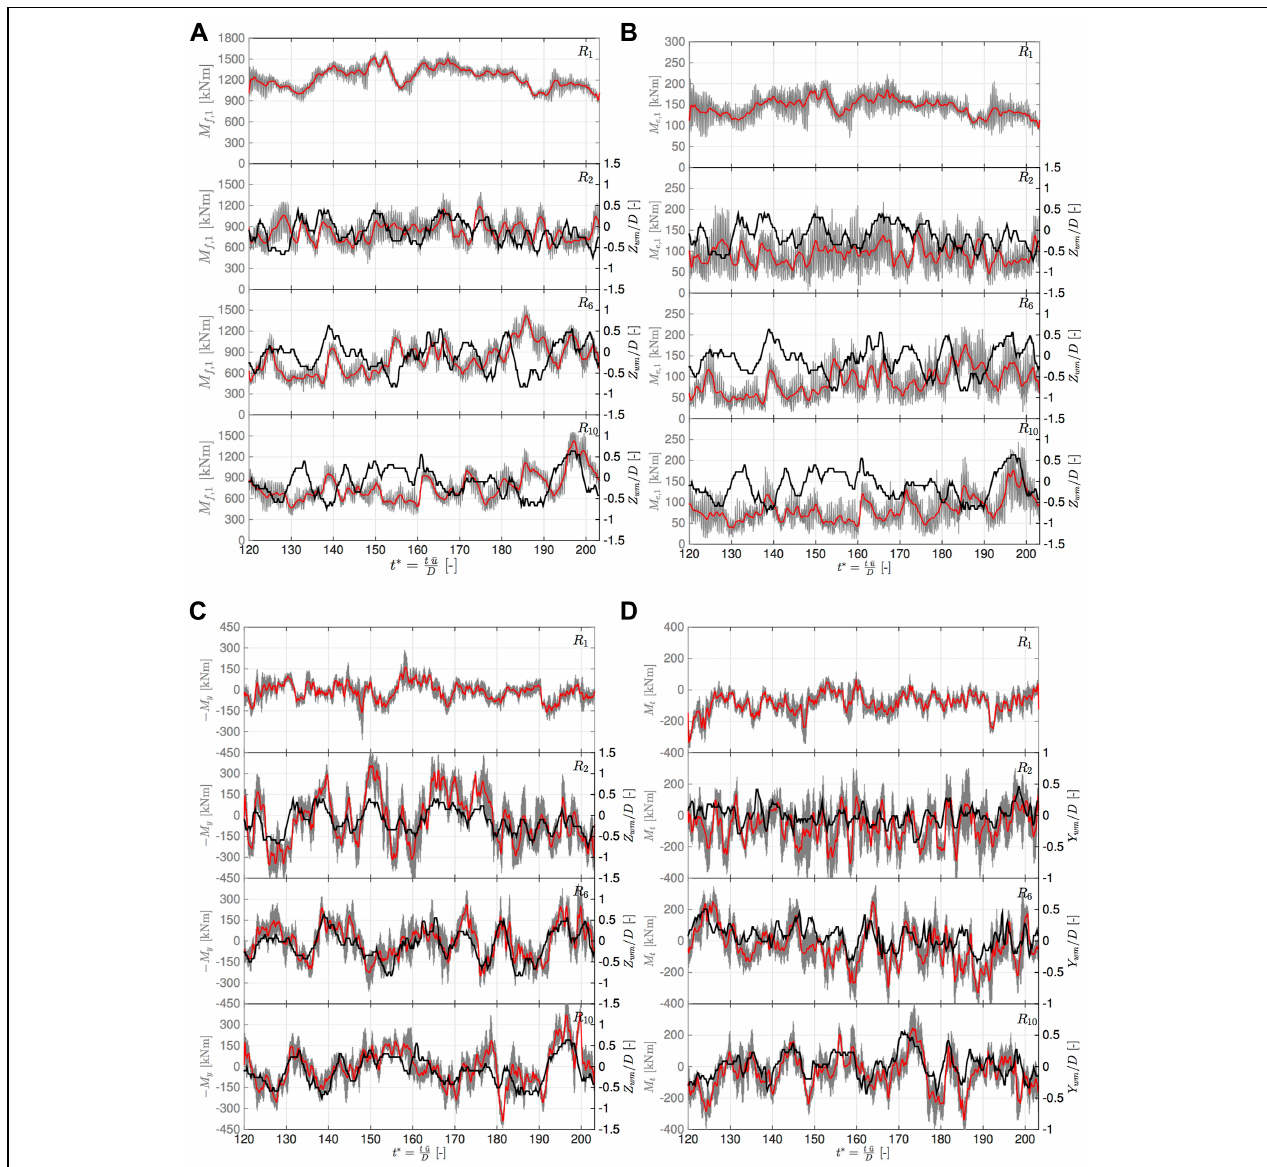
FIGURE 6 | Histories of the flapwise (A) and edgewise (B) root bending moments and of the yaw (C) and tilt (D) moments for α w = 270 ° and rows R 1 , R 2 , R 6 and R 10 (grey lines). The filtered signals of M f , 1 and M e , 1 at f Ω , and of M y and M t at 3 f Ω are also added (red lines). The wake centerline position just upstream of the machine is also reported for rows R 2 , R 6 and R 10 (black